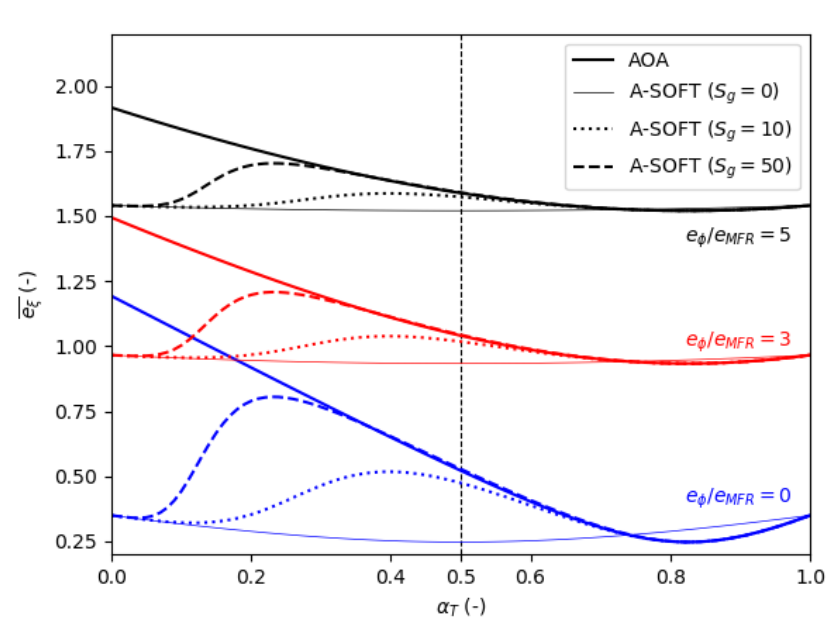
Figure 6. Normalized thrust errors.